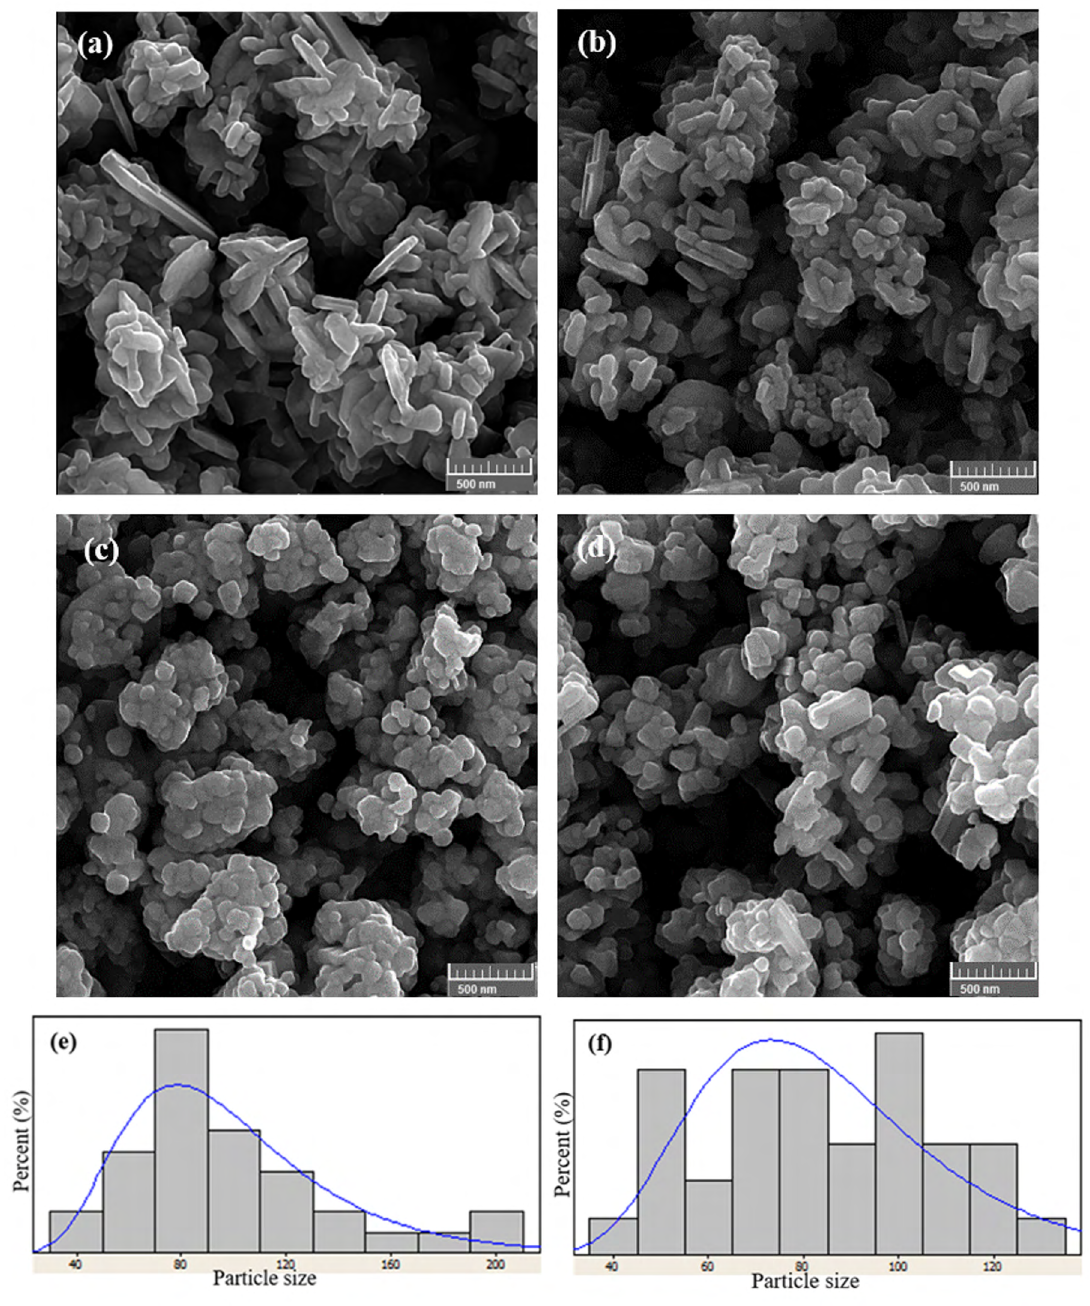
Figure 1. FESEM images of A1, A2 and A3 samples with different amount of oxalic acid and PEG: (a) and (b) 32.7 and 1; sample A1, (c) 49 and 2; sample A2, and (d) 65 and 4 mmol; sample A3, respectively; (e) and (f) particle size distribution for Figure 1(b) and Figure 1(c),